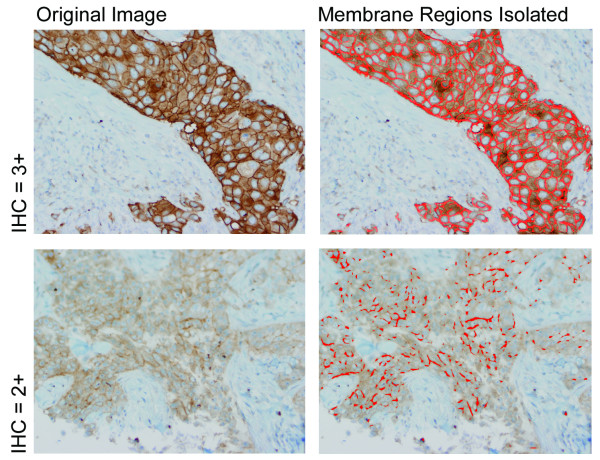
Results of the membrane isolation algorithm. Two examples of HER2 images (left column) taken from a manually graded 3+ case (top row) and 2+ case (bottom row) with their isolated membrane regions (right column). Images are captured at 20× magnification and stained with DAB and hematoxylin.